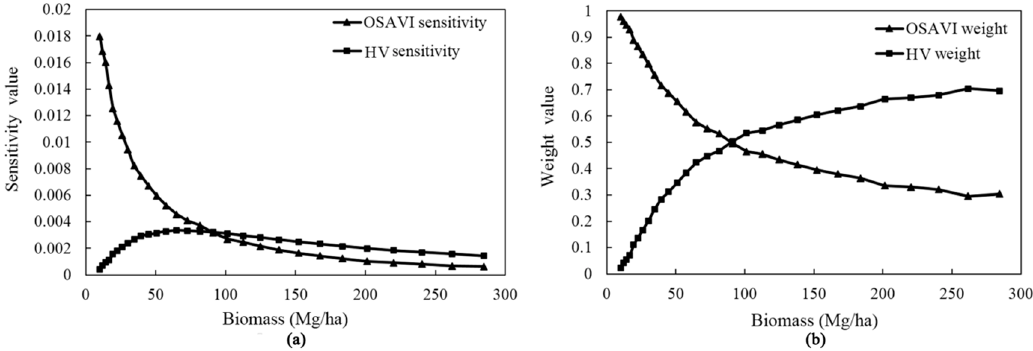
Figure 5. Sensitivity variation ( a ); and weight variation ( b ) of OSAVI and HV with increasing biomass.